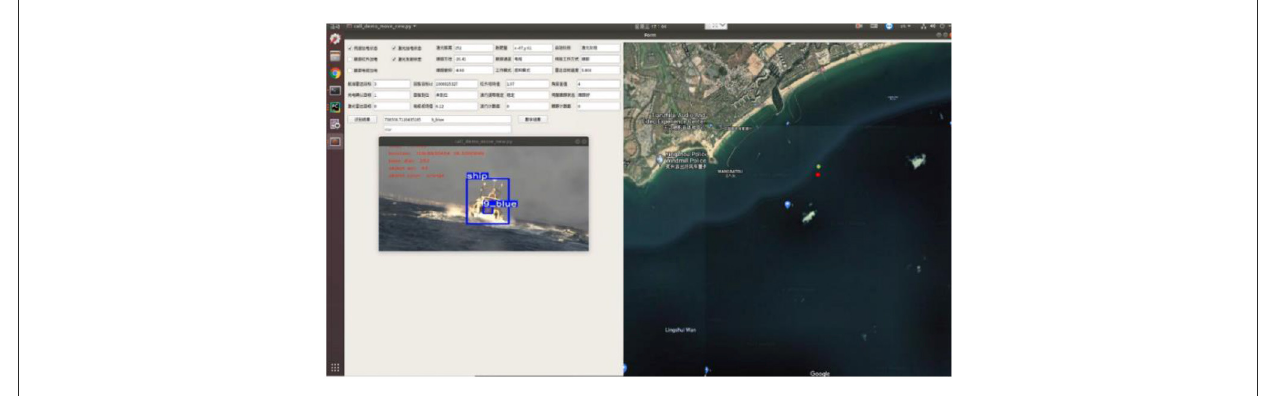
FIGURE10 The software interface for perception system in USV.